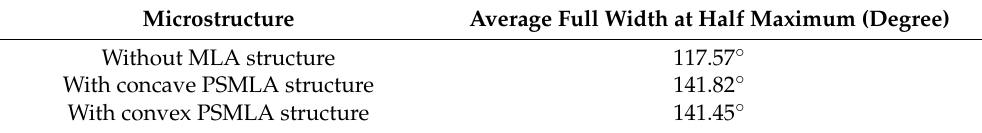
Table 2. Simulation of the light guide layer with various MLA microstructures.